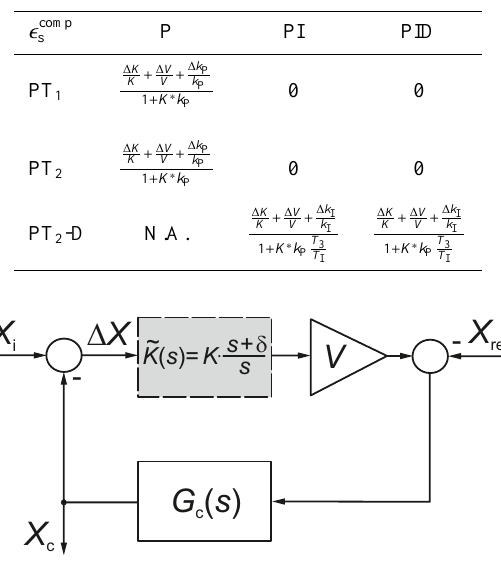
Table 7. Systematic static deviations of the closed-loop sensor for all sensor-controller combinations.